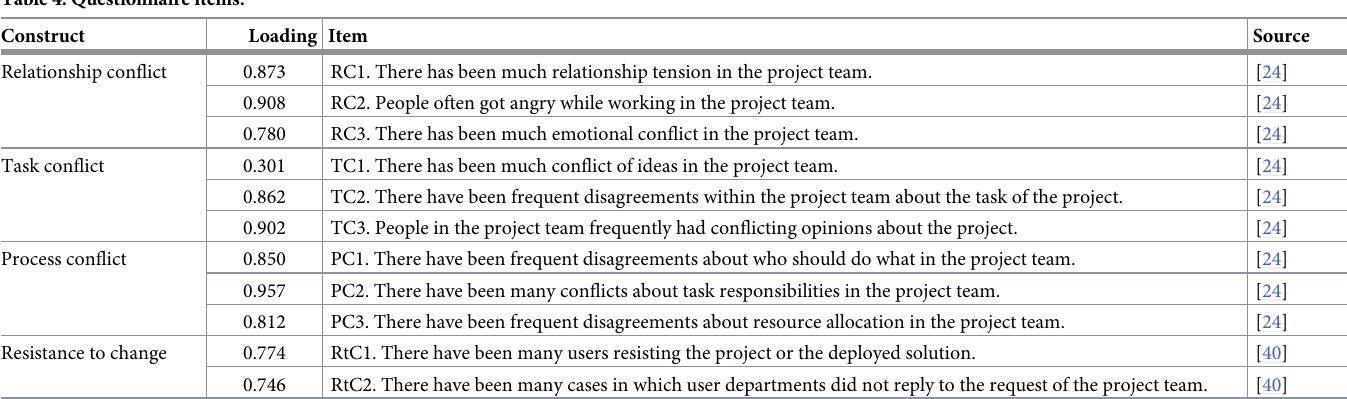
Table 4. Questionnaire items.